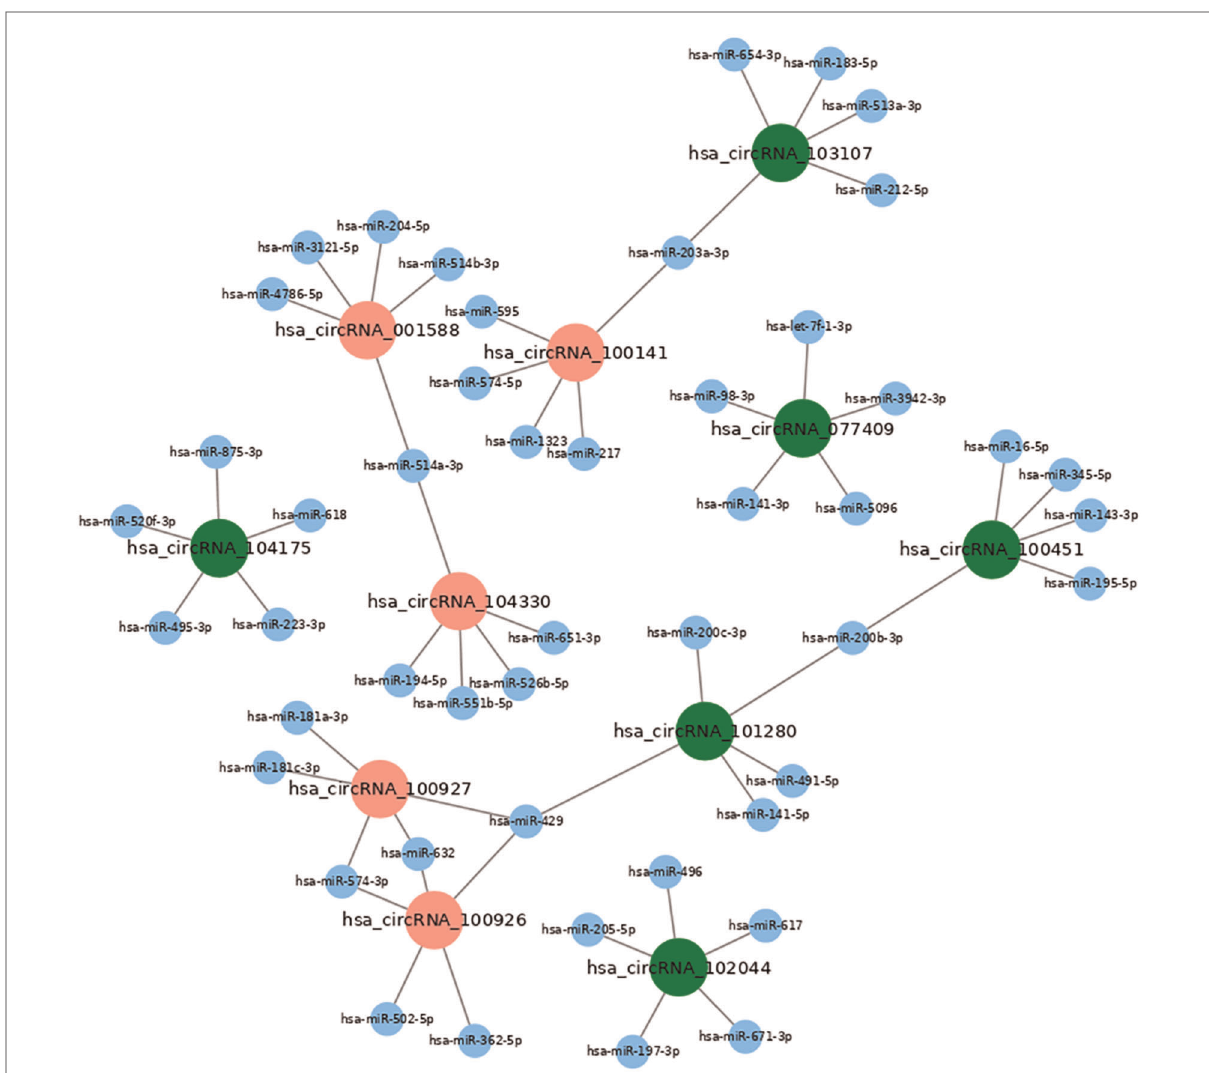
FIGURE 6 CeRNA network map of differentially expressed miRNAs and circRNAs in diabetic wound tissues. The ceRNA network is based on circRNA/miRNA and mRNA/miRNA interactions. In this network, circRNA expression is associated with mRNAs through miRNAs. The results showed that miR- 223-5p and miR-144-5p are up-regulated in diabetic patients with chronic refractory wounds; hsa_circRNA_104175 is down-regulated and is related to miR-223-5p. miR-203-3p, miR-205-5p, miR-514a-3p, miR-200c-3p and miR-141-3p are down-regulated. Hsa_circRNA_100141 is up- regulated, hsa_circRNA_ 103107 is down-regulated, and both are related to the regulation of mir-203-3p. Hsa_circRNA_ 102044, hsa_circRNA_101280, hsa_ circRNA_077409 are down-regulated and related to the regulation of miR-514a-3p, miR-200c-3p, and miR-141-3p; Hsa_circRNA_001588 and hsa_circRNA_104330 are upregulated and are related to miR-514a-3p regulation; Hsa_circRNA_100451 and hsa_circRNA_101280 are downregulated and related to miR-200b-3p regulation; Hsa_circRNA_100926 and hsa_ circRNA_100927 are